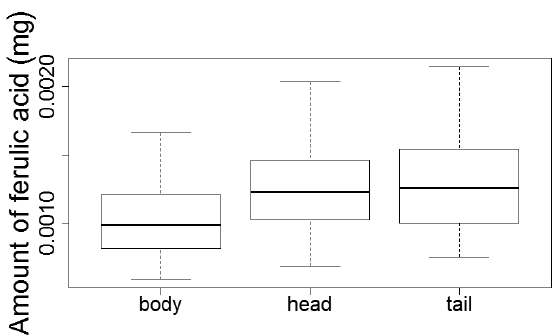
Figure 5. Amounts of ferulic acid between parts of the root. Error bars represent the 95% confidential intervals (head, n = 20; body, n = 19; tail, n = 19).